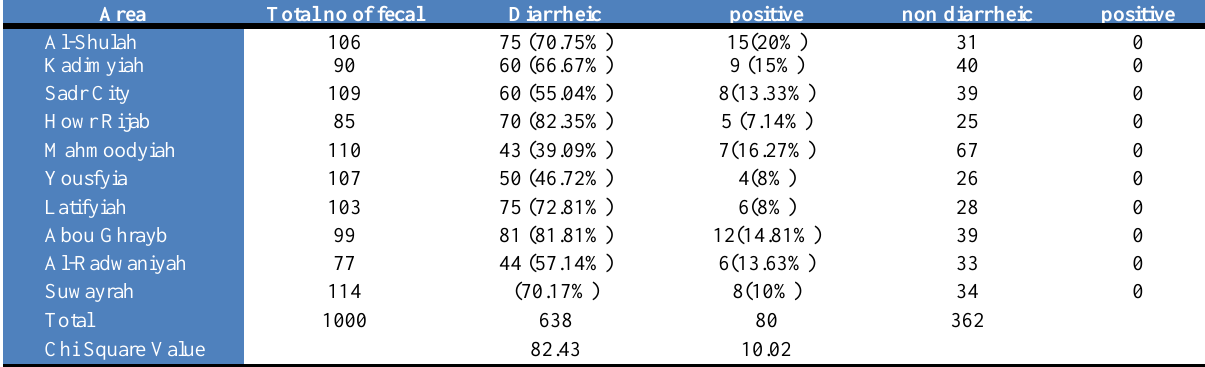
Table, 3: Percentage of positive diarrheic cows and percentage of positive diarrheic to Campylobacter isolates.